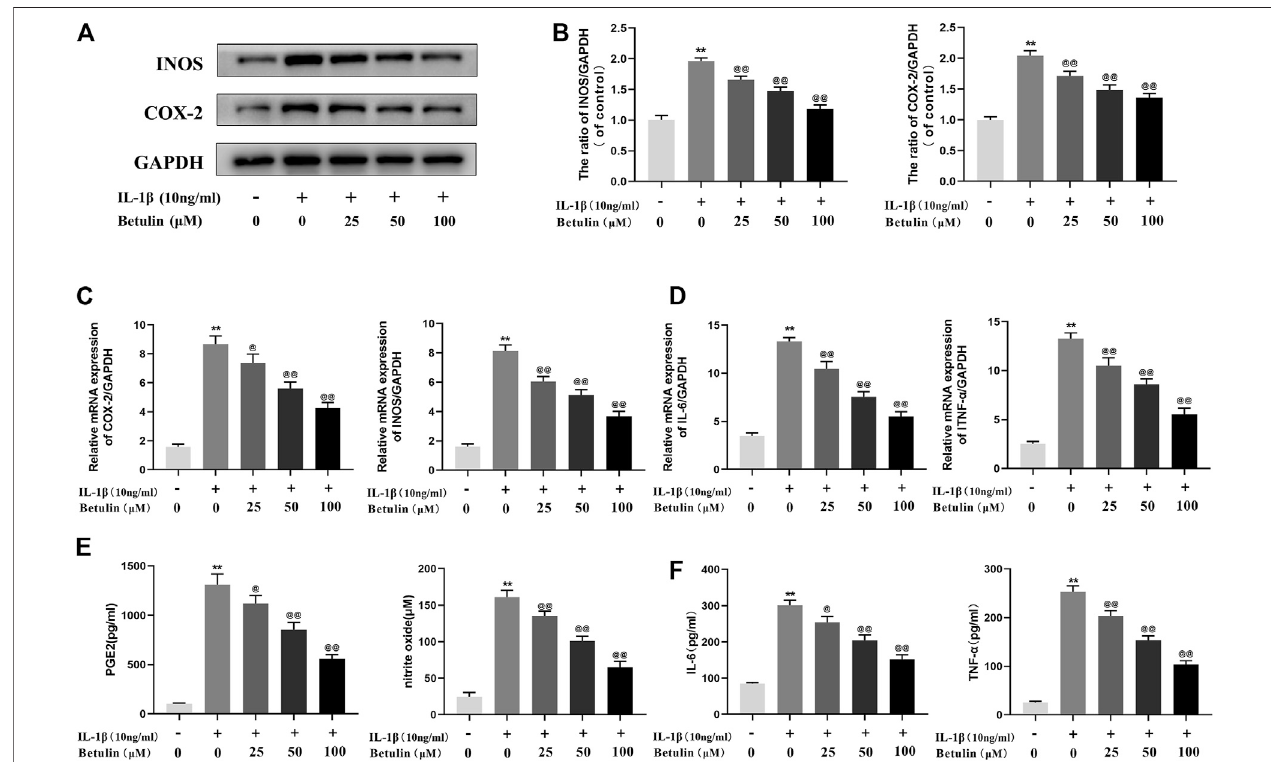
FIGURE 2 | Betulin treatment can inhibit the generation of pro-in fl ammatory mediators. OA chondrocytes were pretreated with betulin (0, 25, 50, and 100 μ M) of different concentrations for 2 h, then stimulated by IL-1 β (10 ng/ml) for 24 h. (A – B) The protein expression of iNOS and COX-2 was detected by Western blot and quantitativelyanalyzed. (C – D) ThemRNAexpressionlevelsofiNOS,COX-2,IL-6,andTNF- α weredetectedbyRT-PCR. (E – F) ThegenerationofNO,PGE2,TNF- α ,and IL-6 was detected by Griess reaction and the ELISA method. The data in the fi gure are represented as the average ± SD, * p < 0.05, ** p < 0.01 compared with the control group, @@ p < 0.01 compared with the IL-1 β group, n (cid:2)